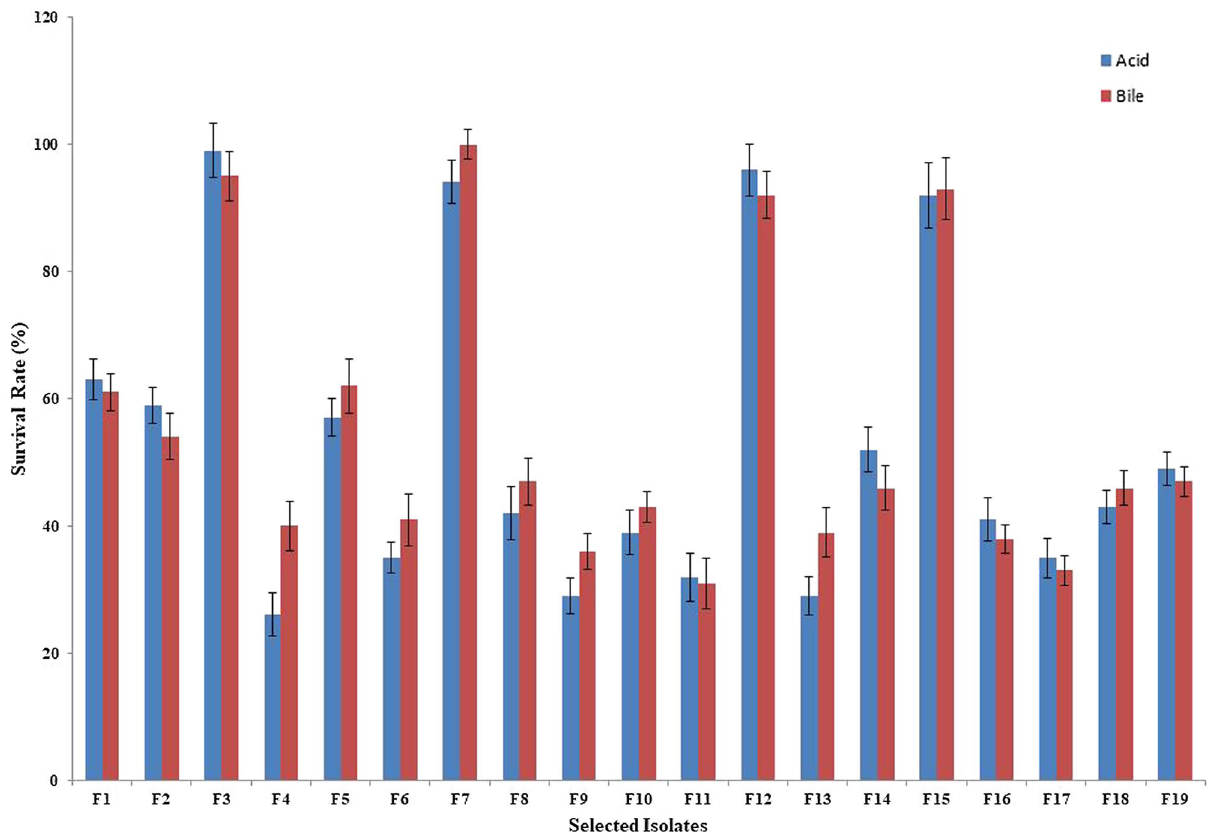
Figure 2. Tolerance of isolates to low pH and high bile salt